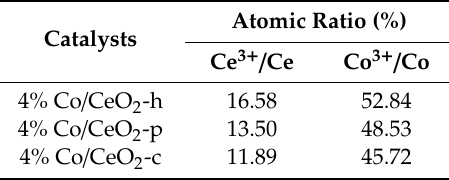
Table 3. The relative concentrations of di ff erent valence elements surface atomic Ce,